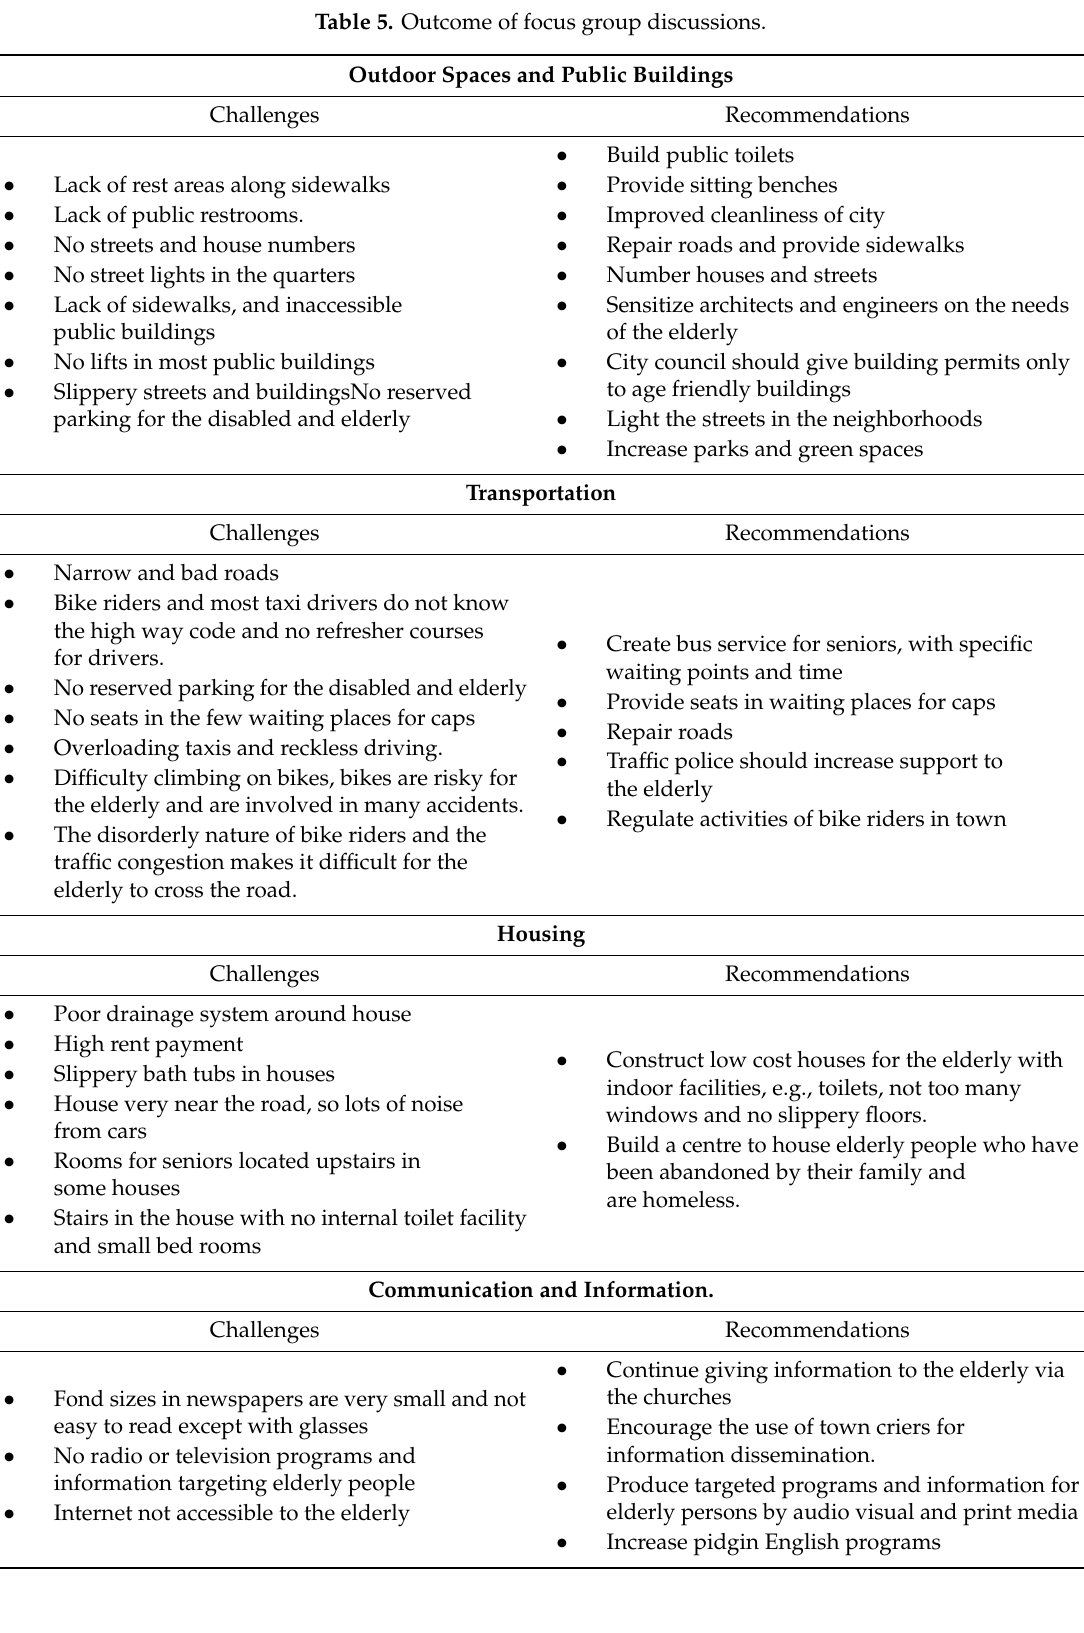
Table 5. Outcome of focus group